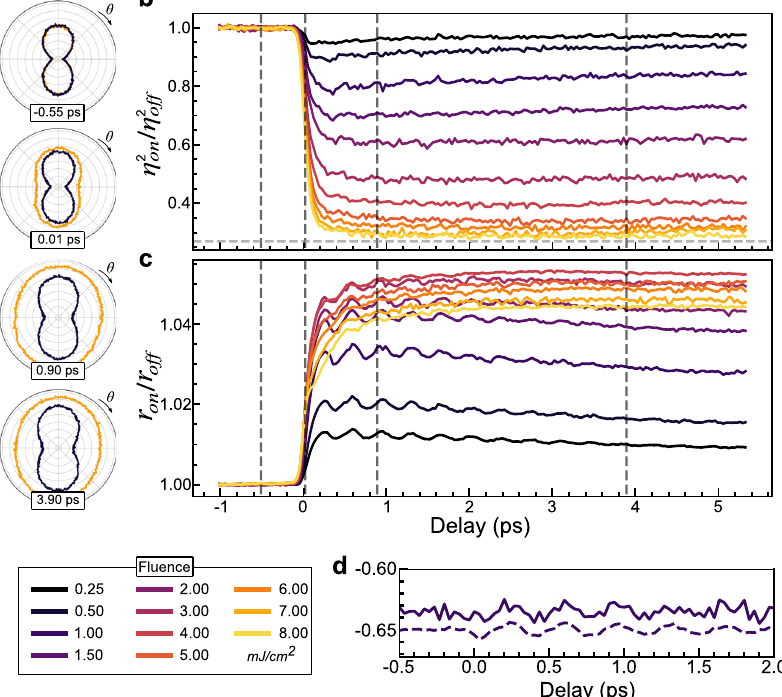
Fig. 3 Time-dependent re fl ection anisotropy measurements of LSMO during the photoinduced phase transition. a RA patterns as a function of pump- probe time delay for high (orange) and low (black) fl uence. The radial axis runs from 1.63 to 2.015, with divisions every 0.05 (arb. units). b Ultrafast evolution of the normalized order parameter ƞ 2 as a function of pump fl uence which shows an ultrafast suppression. c Ultrafast evolution of the isotropic re fl ectivity r , showing a coherent phonon oscillations at 2.7 THz. d comparison of ƞ 2 and r at 0.5 mJ cm − 2 showing the 2.7 THz mode weakly modulates the RA signal. Supplementary Video 1 and Supplementary Video 2 show the RA pattern of each time delay for pump fl uences of 1.5 and 8 mJ cm − 2 , respectively, together with the corresponding plots of r and ƞ 2